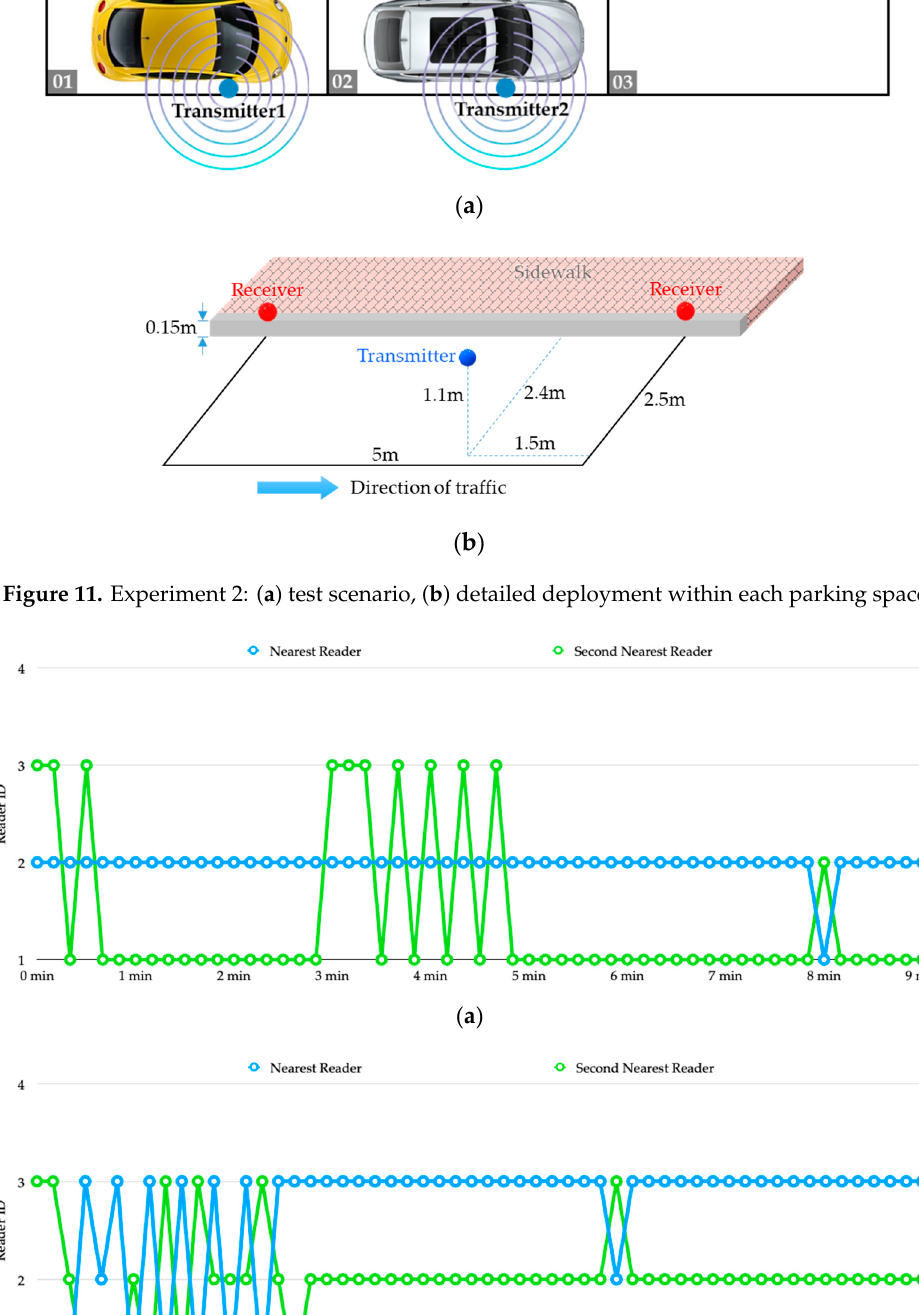
Figure 12. Experiment 2: ( a ) determination of occupancy for vehicle 1, ( b ) determination of occupancy for vehicle